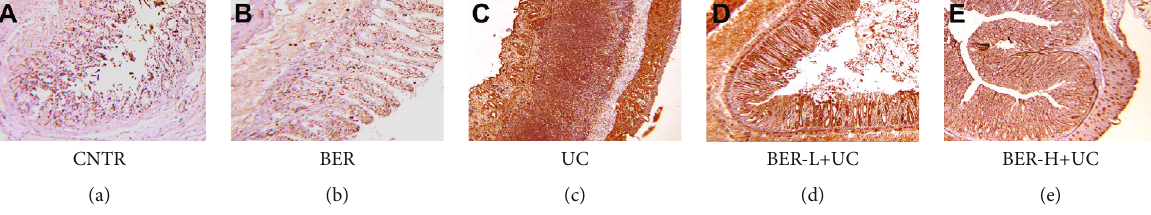
Figure 8: Berberine supressing the protein expressions of TGF- β in colonic tissue of experimental colitis in rats. (a) Colon from the CNTR group (intact group). (b) Colon from the BER group (without ulceration rats). (c) Colon in experimental colitis, untreated group. (d) Colon in BER low dose (25 mg/kg) and experimental colitis, treated group. (e) Colon in BER high dose (50 mg/kg) and experimental colitis, treated group. All the images were taken at a 100x magni fi cation.